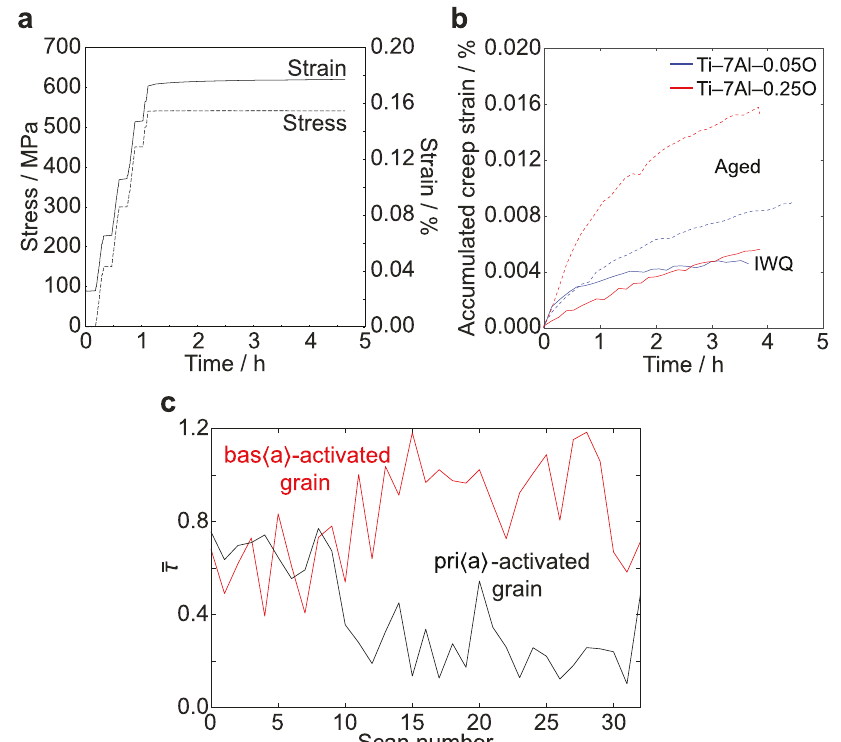
Fig. 3 | Macroscopic and grain-level loading histories from the in situ creep experiment. a Example of macroscopic loading conditions, with steps in applied stress to achieve the desired initial strain rate. b Creep strain response of low- and high-oxygen alloys in the quenched and aged conditions. c The ff-HEDM data